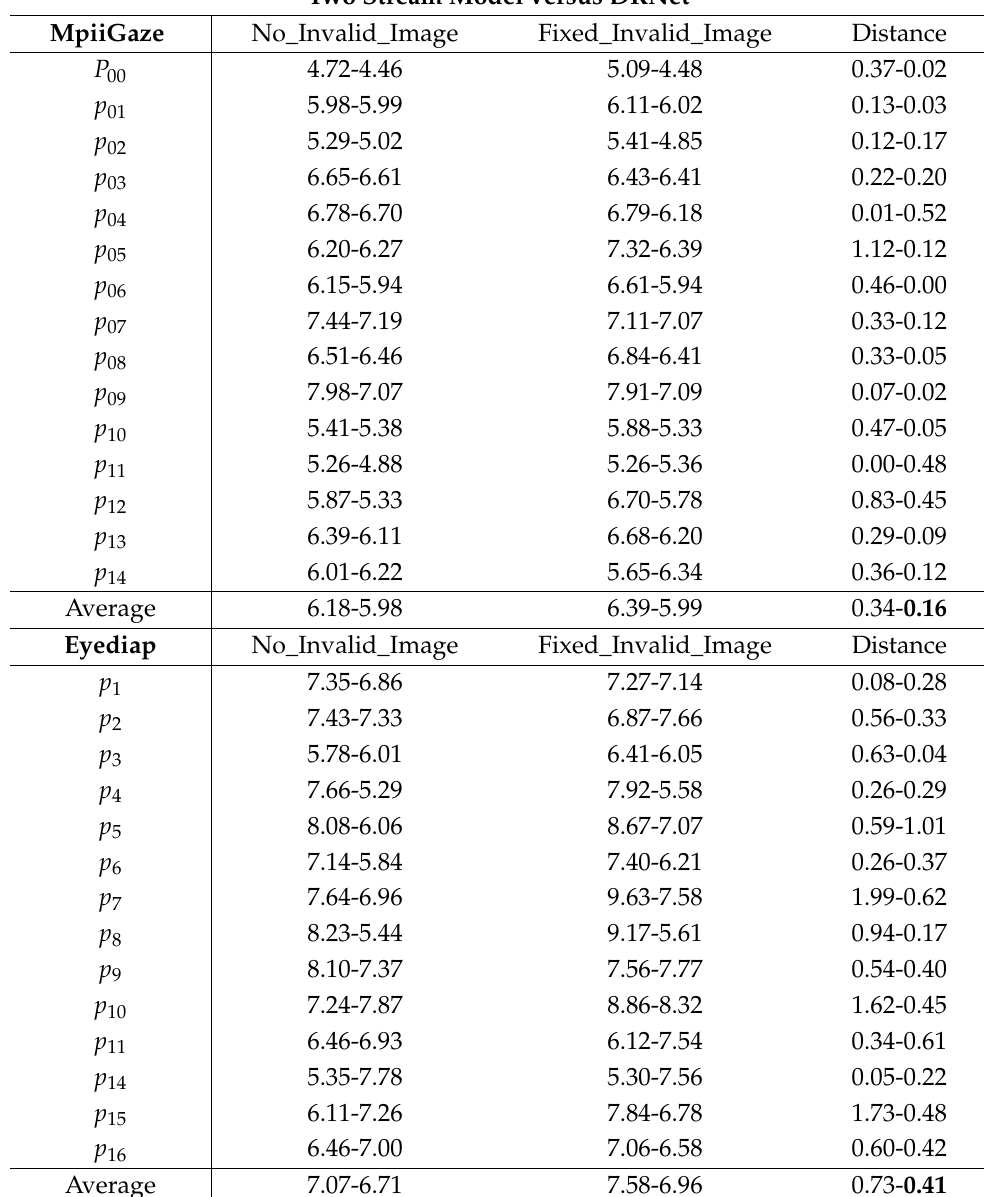
Table 3. Summary of angular-error and absolute distance for robustness evaluation in the two-stream and DRNet model.